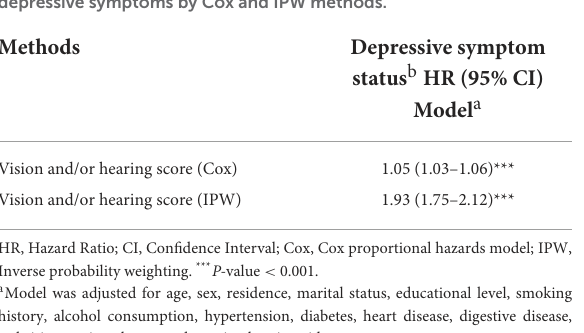
TABLE 5 Associations between vision and hearing scores and depressive symptoms by Cox and IPW methods.